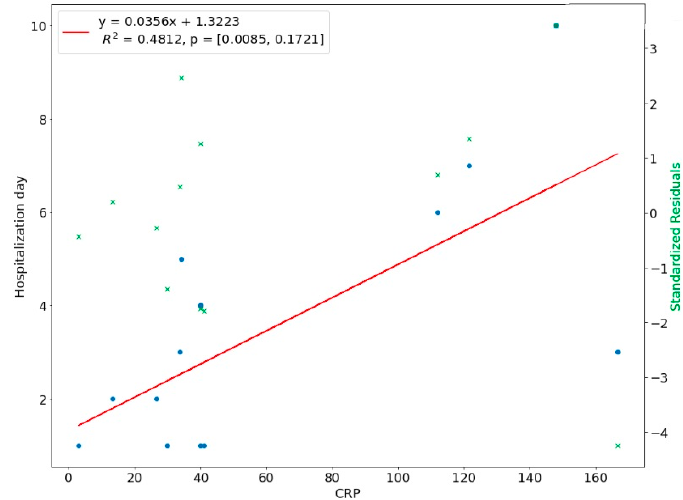
Figure 8. Correlation of NLR with length of hospital stay in upper face odontogenic infections.